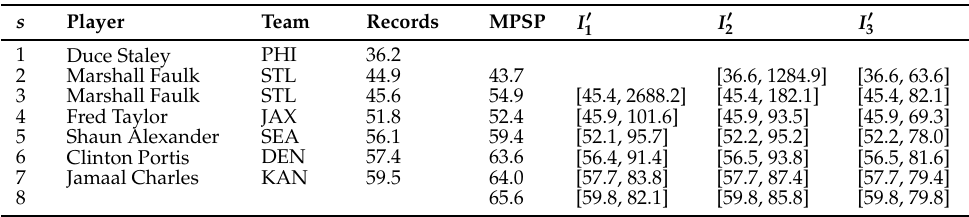
Table 7. World records (2000–2019), maximum product of spacings predictor and (approximate) 90% prediction intervals I (cid:48) , I (cid:48) and I (cid:48) for the next record based on the previous records for the fantasy 2 3 1 points of running